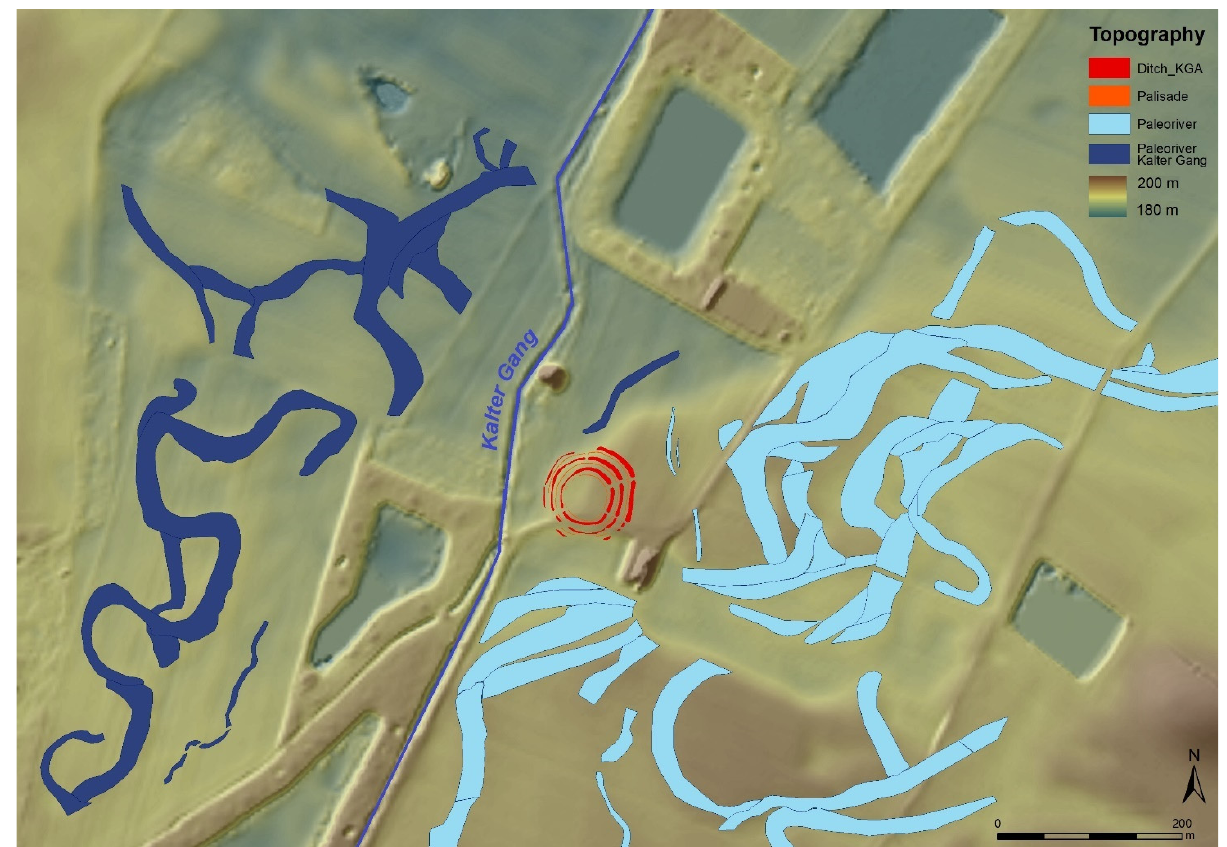
Figure 13. The digital elevation model of the surroundings of the KGA Velm showing the depression generated by the erosion of the river Kalter Gang (dark blue). The system of paleo-rivers to the east must have been part of an older river system (light blue).